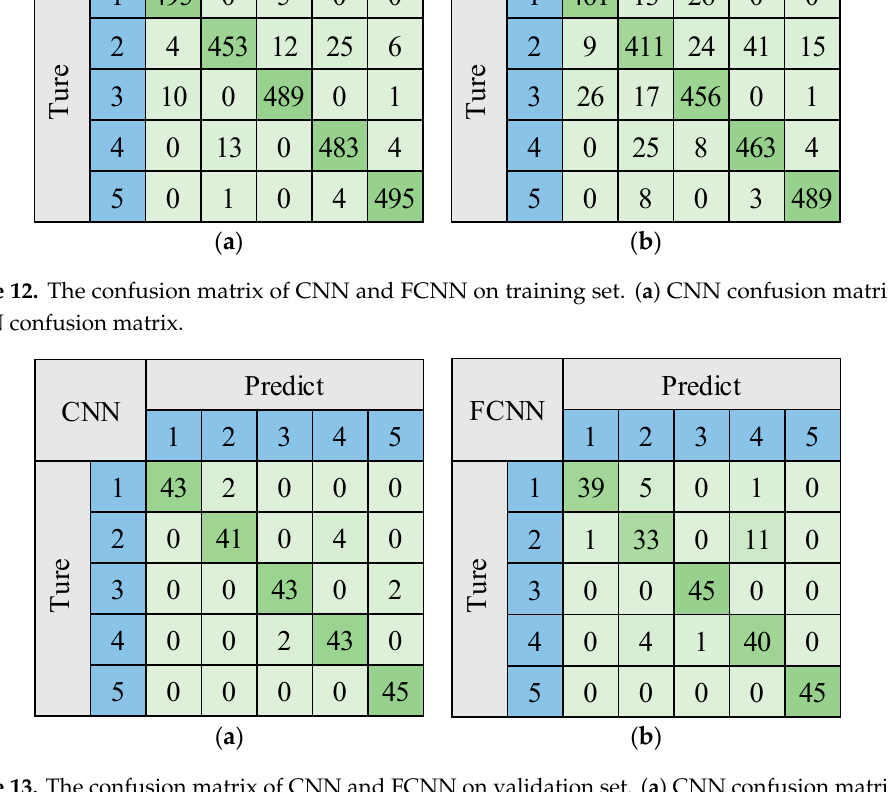
Figure 13. The confusion matrix of CNN and FCNN on validation set. ( a ) CNN confusion matrix; ( b ) FCNN confusion matrix. Table 7. The evaluation result of FCNN and CNN on training set.